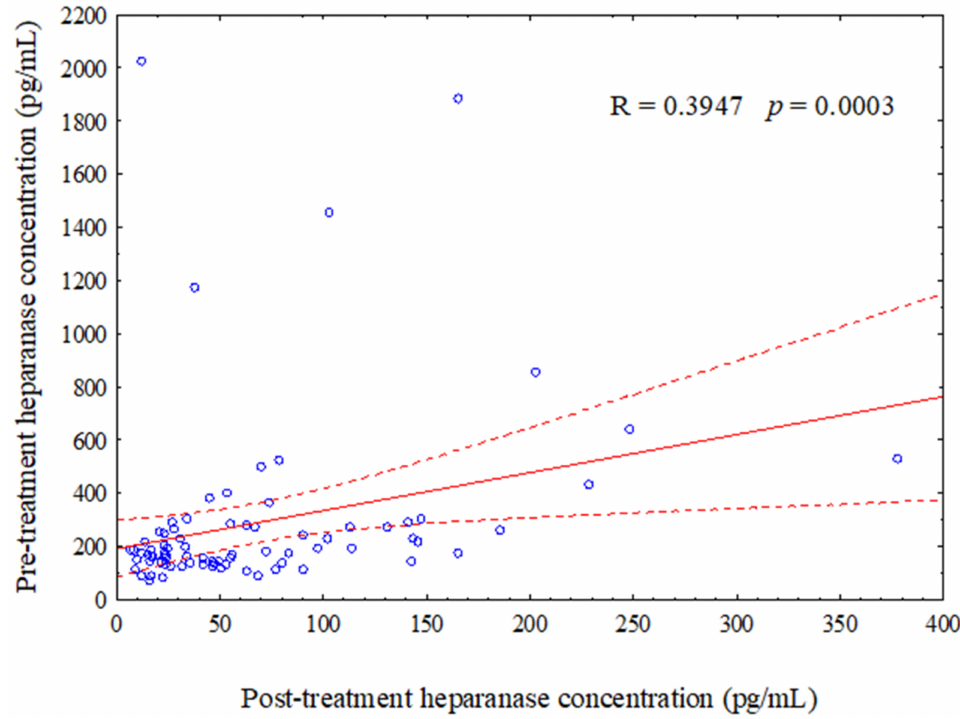
Figure 1. Scatter plot shows a positive of correlation between a pre-treatment with a post-treatment concentration of